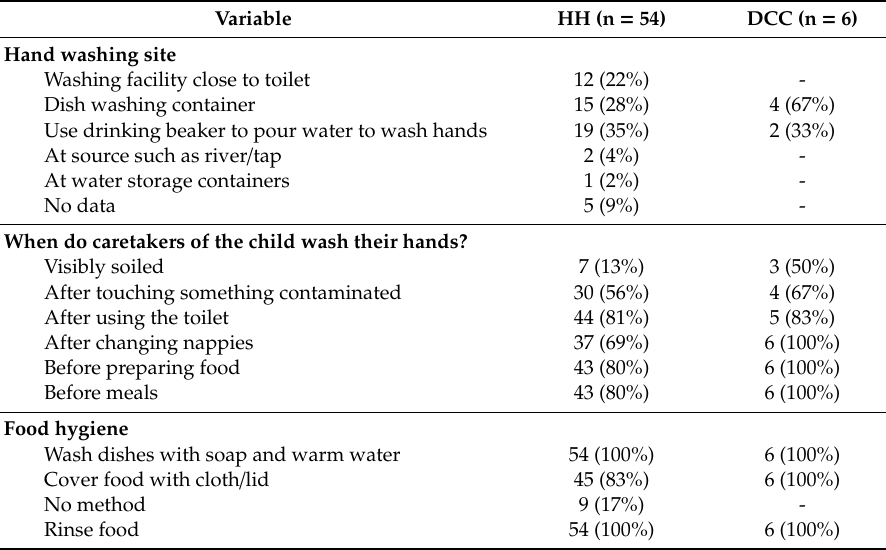
Table 4. Descriptive hygiene demographics for the study households and